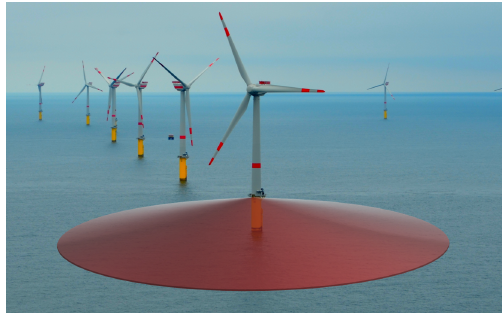
Figure 3. Schematic representation of the sea surface levelling scan from the transition piece platform of a turbine at the Global Tech I wind